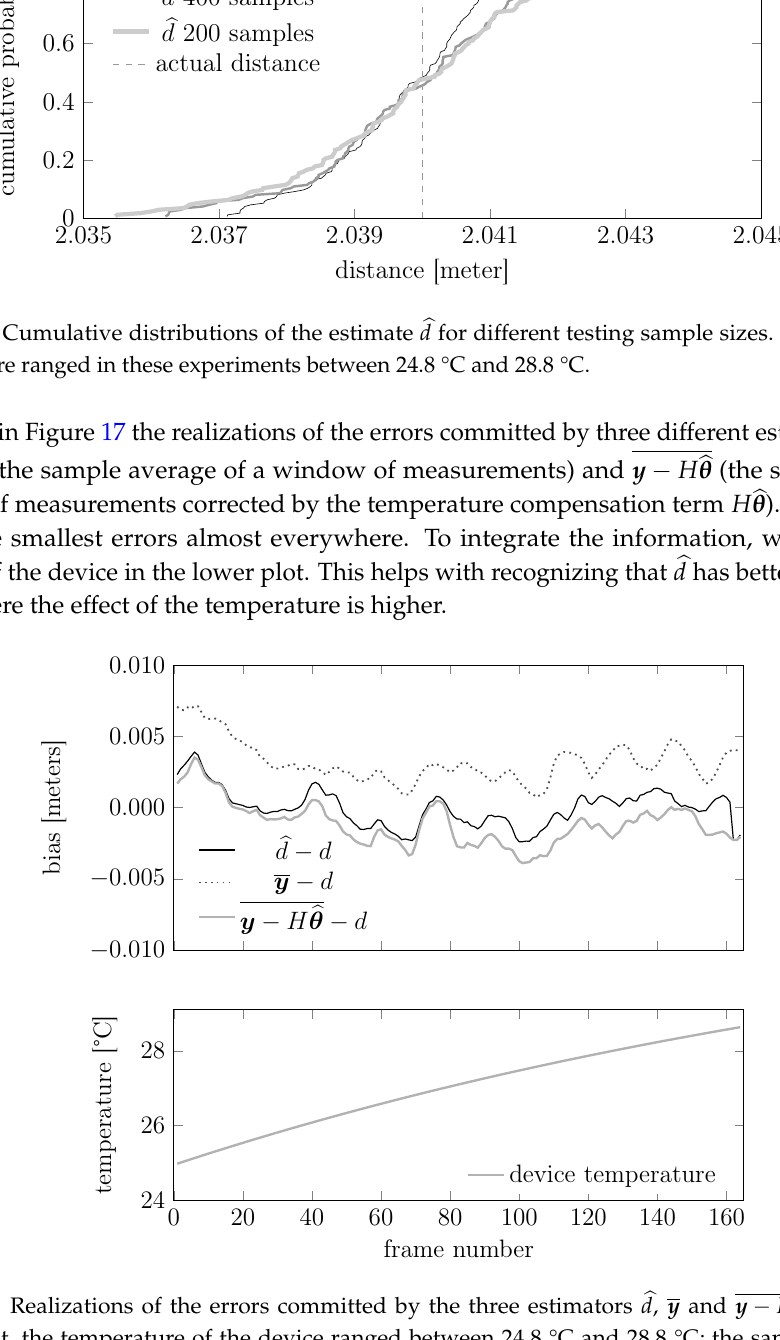
Figure 17. Realizations of the errors committed by the three estimators experiment, the temperature of the device ranged between 24.8 °C and 28.8 °C; the sample size is 1000